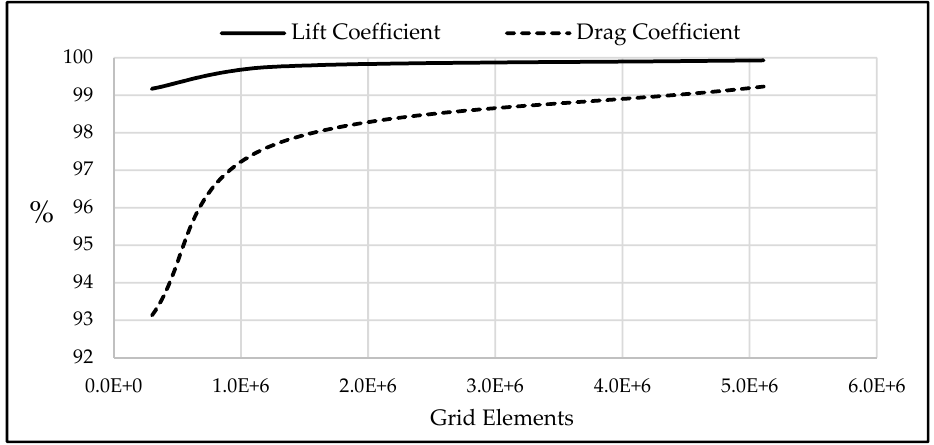
Figure 5. Approximation of the aerodynamic coefficients according to the grid size.